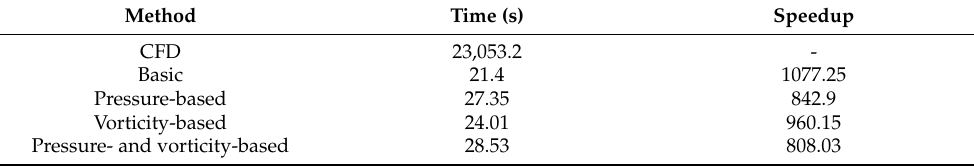
Table 4. Computational time required by each studied method to predict the velocity fields.